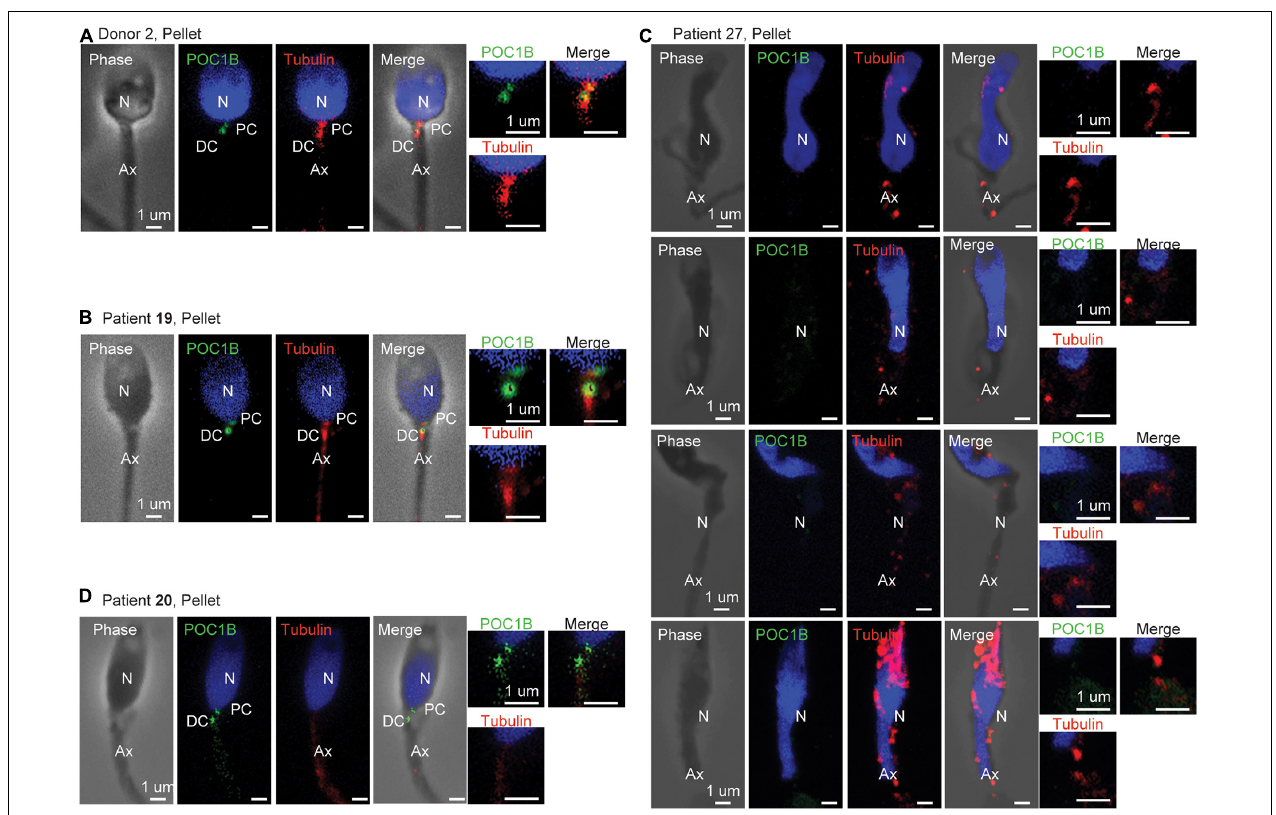
FIGURE 4 | Centriole staining abnormalities. (A) Example of standard staining from the pellet sperm of donor 2, who had a standard semen analysis, and whose centriole ratios fell within 2 SDs of the mean for all mean ratios. (B) Example of standard staining from the pellet sperm of patient 19, who had a standard semen analysis, and whose centriole ratios fell within 2 SDs of the mean for all mean ratios. (C) Example of abnormal staining from the pellet sperm of patient 27, who had a severe oligoasthenoteratospermia phenotype such that the centrioles could not be quantified. (D) Example of abnormal staining from the pellet sperm of patient 20, who had an asthenoteratospermia phenotype, and whose centriole ratios fell more than 3 SDs of the mean for distal centriole POC1B. N, nucleus; PC, proximal centriole; DC, distal centriole; Ax, axoneme.